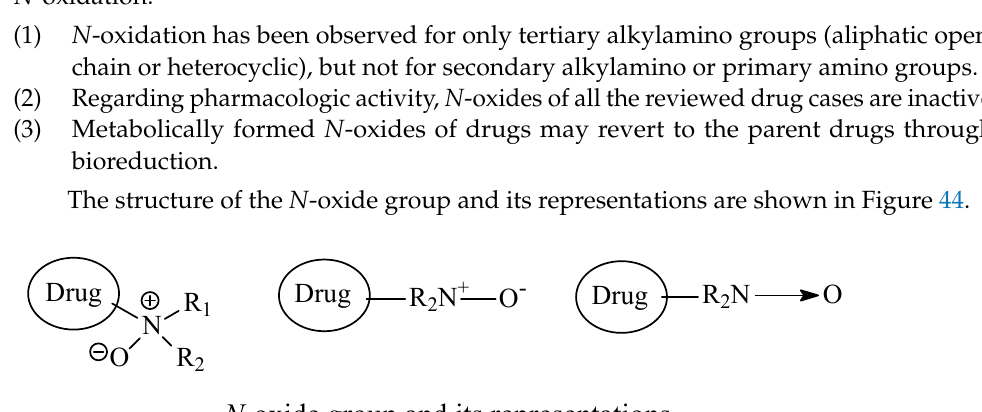
Figure 44. N-oxide group and its